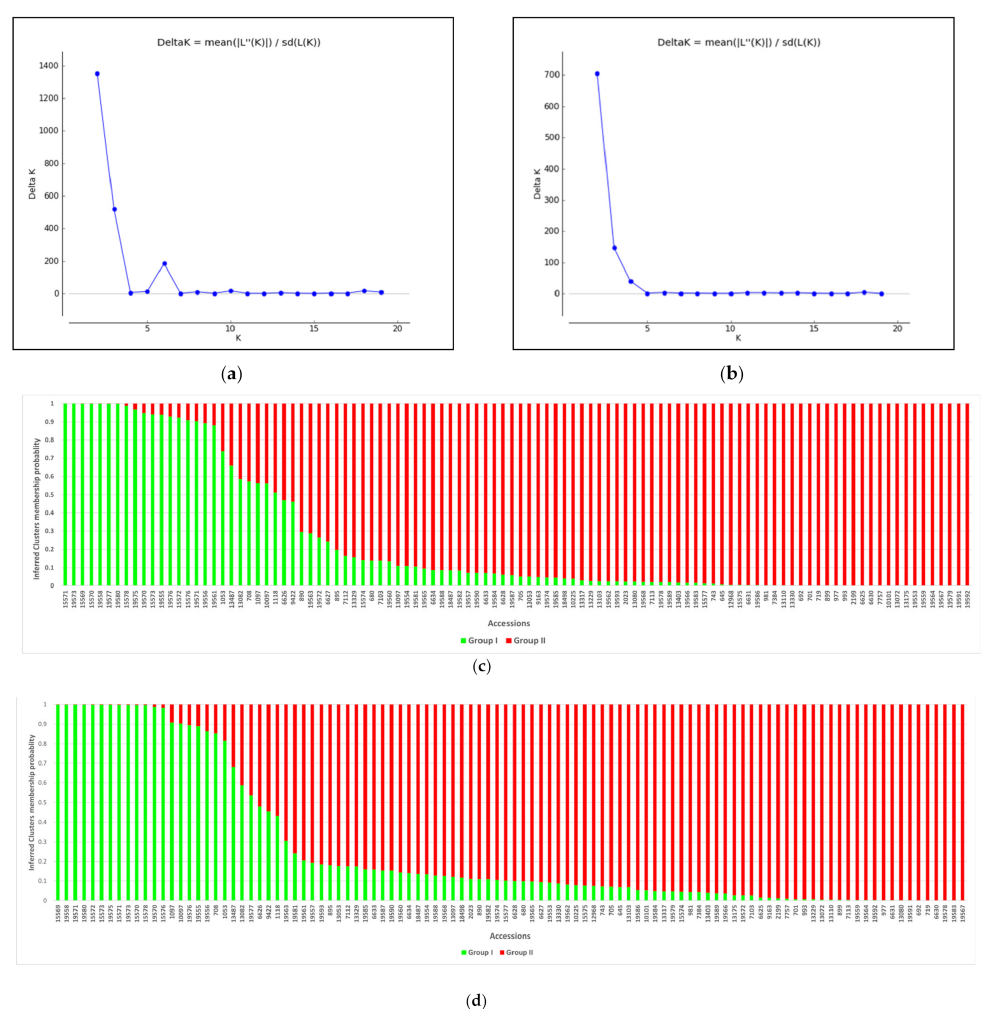
Figure 7. Bayesian assignment of population structure of 104 Rhodes grass accessions: Delta K ( ∆ K) for K = 2 to 20 subpopulations using SNP ( a ) and SilicoDArT ( b ) markers. The STRUCTURE barplot of the estimated membership coefficient (Q) of each accession for K = 2 for SNP ( c ) and SilicoDArT ( d ) markers. Each bar represents the Q of an individual